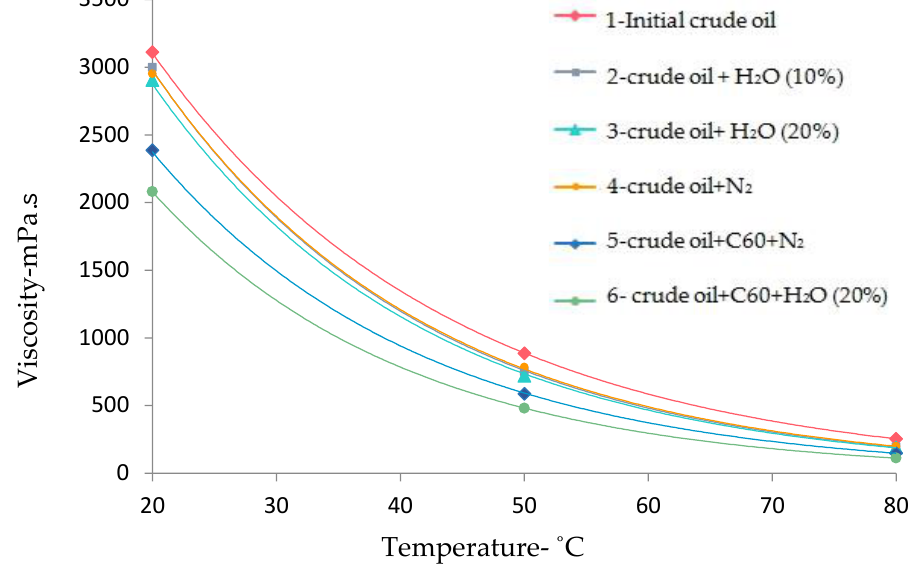
Figure 1. Viscosity–temperature relations in the process of thermolysis in the medium of water Figure 1. Viscosity – temperature relations in the process of thermolysis in the medium of water and and nitrogen.